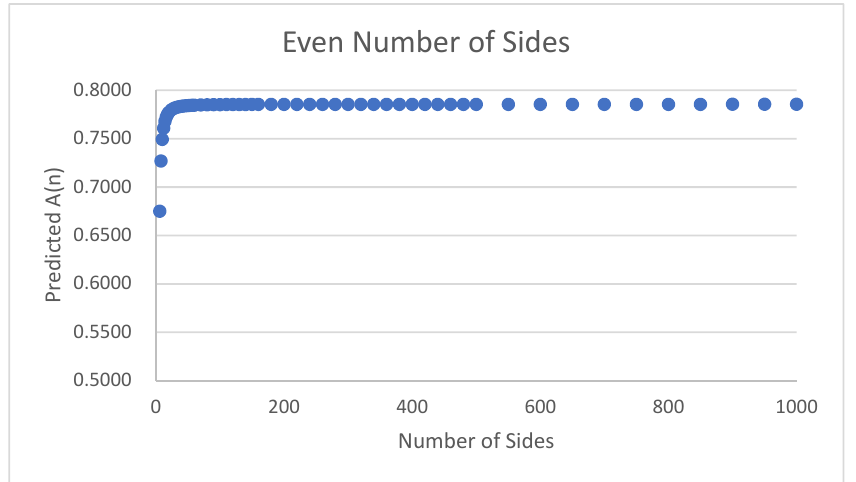
Figure 8. The nonlinear regression model (10) predicting 𝐴(𝑛) shown for even 4 ≤ 𝑛 ≤ 1000 . Since the two sequences closely overlap, the preceding figure depicting observed vs.